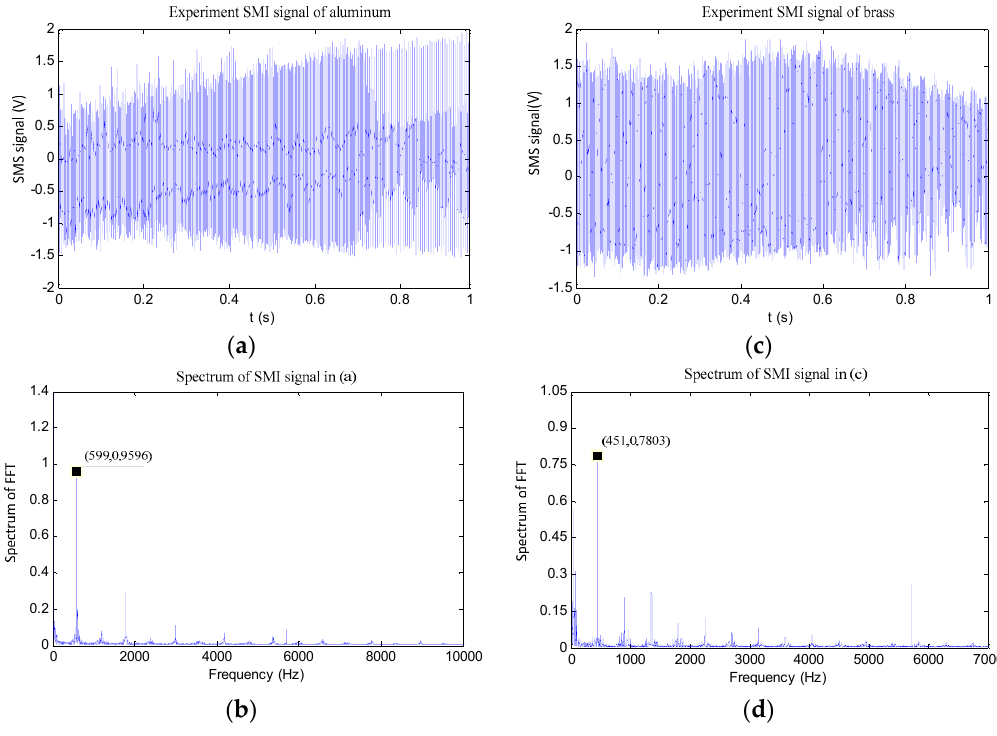
Figure 9. ( a , b ) Experimental results of aluminum 6061; and ( c , d ) experimental results of brass.